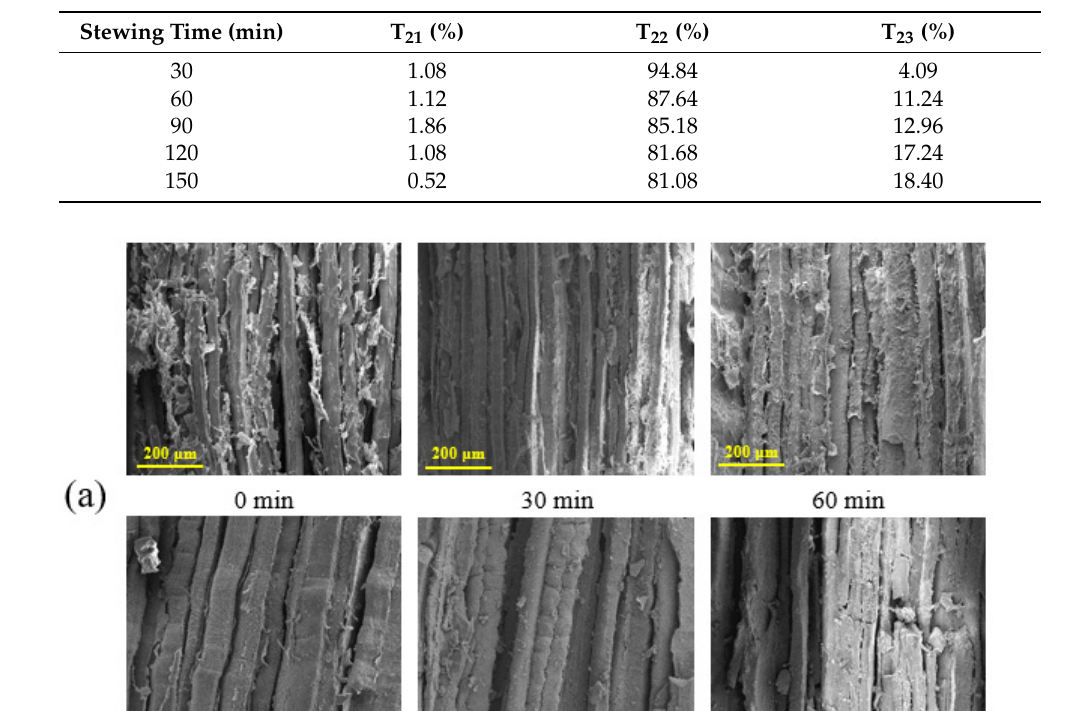
Table 3. Effects of stewing time on the proportion of LF-NMR peaks of Sichuan-style braised beef.